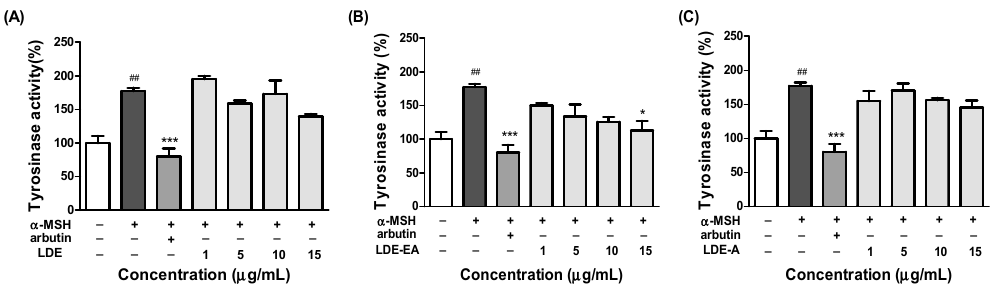
Figure 3. Effect of L. difformis extract on cellular tyrosinase activity in B16F10 cells. Cells were exposed to 200 nM α -MSH in the presence of 1, 5, 10, and 15 µg/mL L. difformis extract (( A ) LDE, ( B ) LDE-EA, and ( C ) LDE-A) or 1 mM arbutin. Each percentage value for the treated cells was reported relative to that of the control cells. Values are represented as the mean ± SEM of three independent experiments. Note: ## p < 0.01 compared with the control; * p < 0.05, and *** p < 0.001 compared with the α -MSH-treated control.